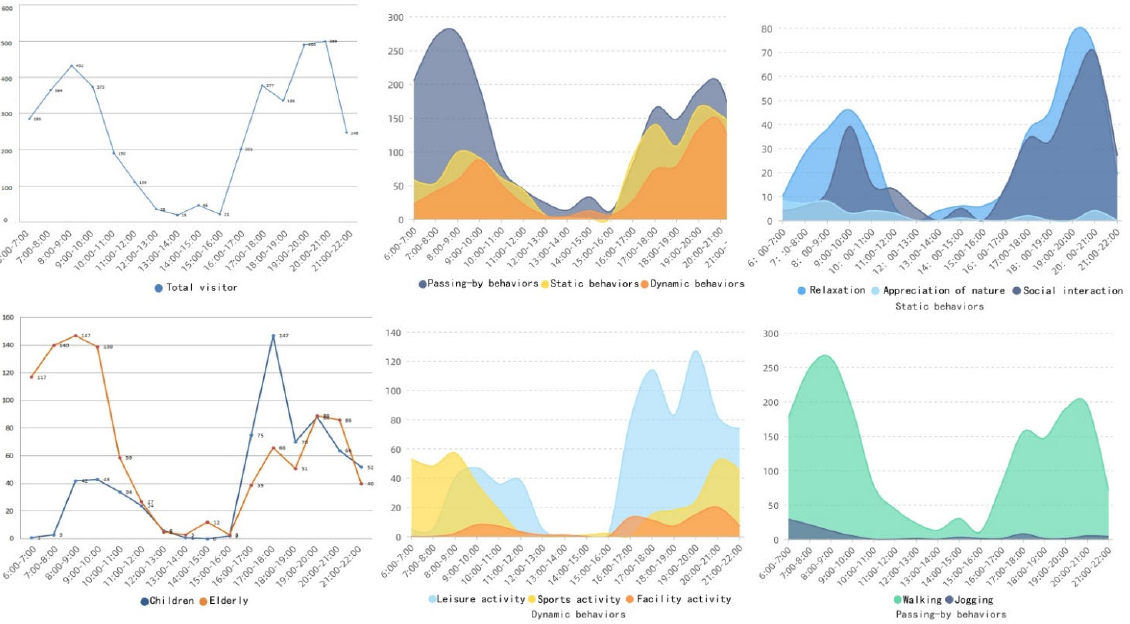
Figure 7. Time differences in each recreational behavior